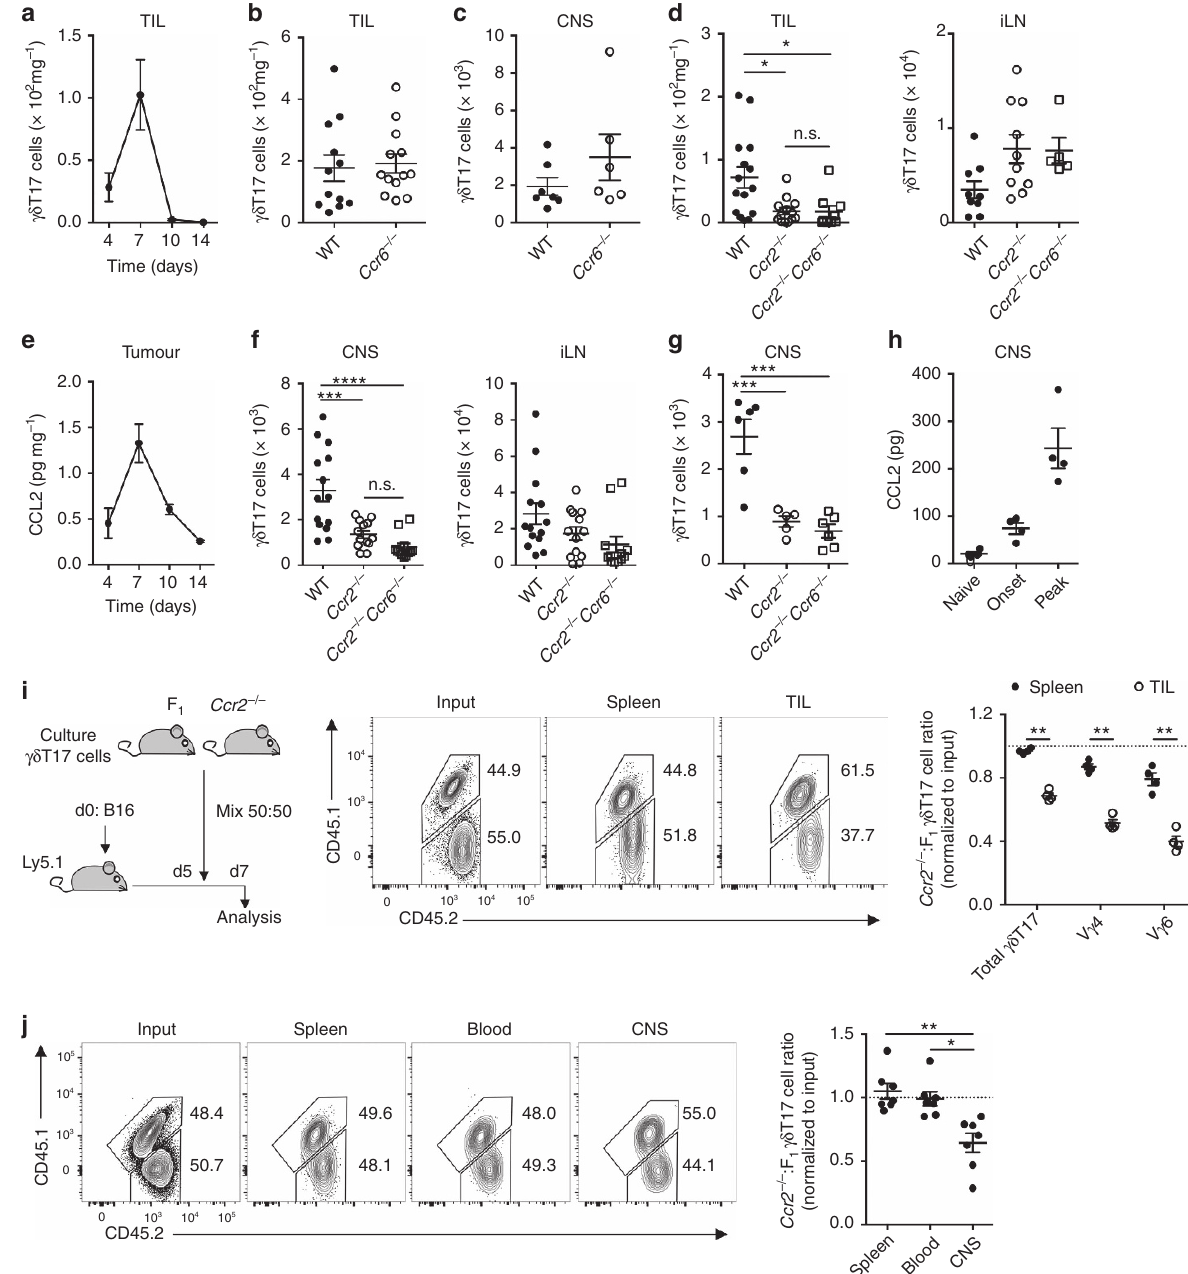
Figure 2 | CCR2 recruits cd T17 cells to inflammatory sites. ( a ) CD45 þ CD3 þ TCR gd þ IL-17A þ gd T17 cell numbers in tumour-infiltrating